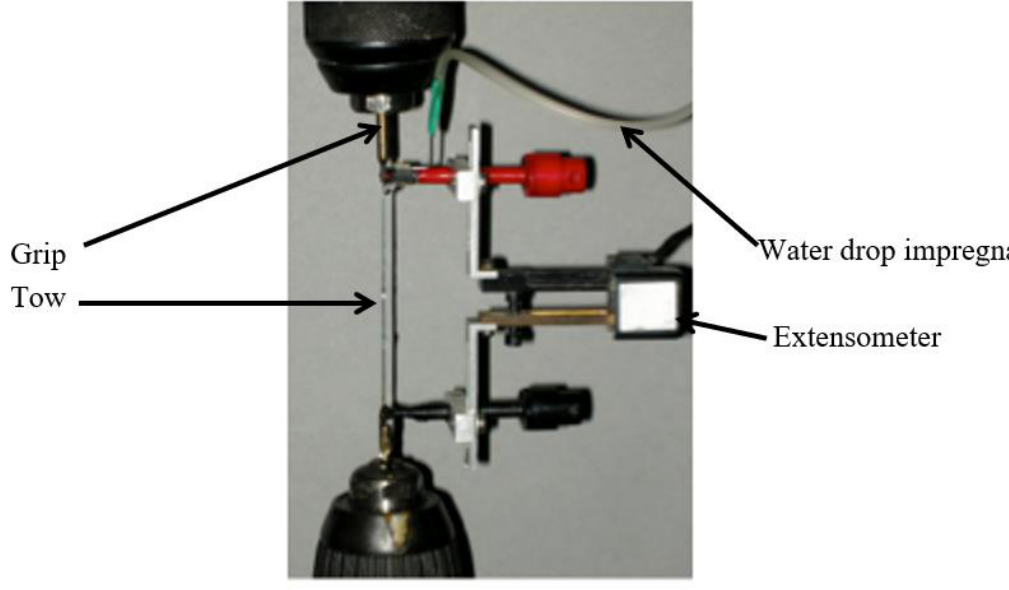
Figure 1. Experimental setup for tensile tests and static fatigue tests on fibre tows.